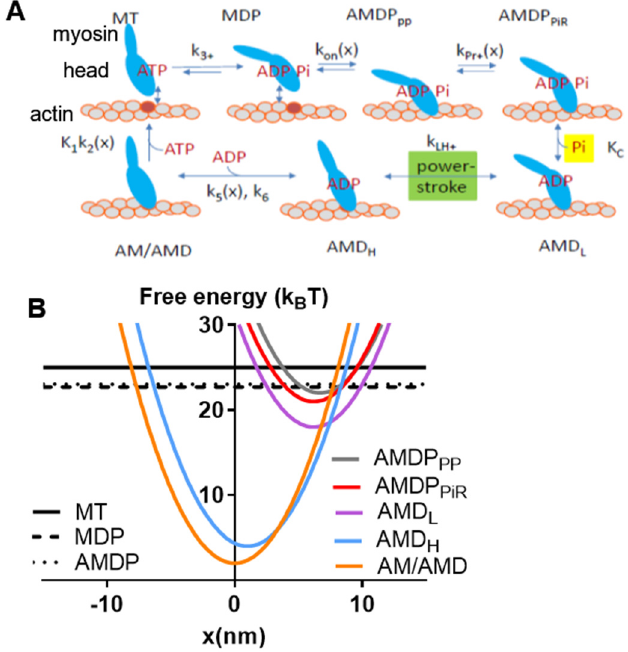
Figure 1. Key transitions and model states with characterization of major states. ( A ) Schematic illustration of myosin head states, including their coarse-grained structure in interaction with actin. The model states are encoded by the letters in the boxes, where A and M denote actin and myosin, respectively, and T, D, and P denote substrate and products, respectively (see further text). The subscripts PP and PiR denote a pre-power stroke state and a Pi-release state, respectively, as defined previously [6,46]. The subscripts L and H are defined in the text. Upper-case and lower-case letters for transition constants refer to equilibrium constants and rate constants, respectively. The argument x indicates the strain dependence of the constant. ( B ) Free energies of the states defined in A as a function of the strain variable, x .